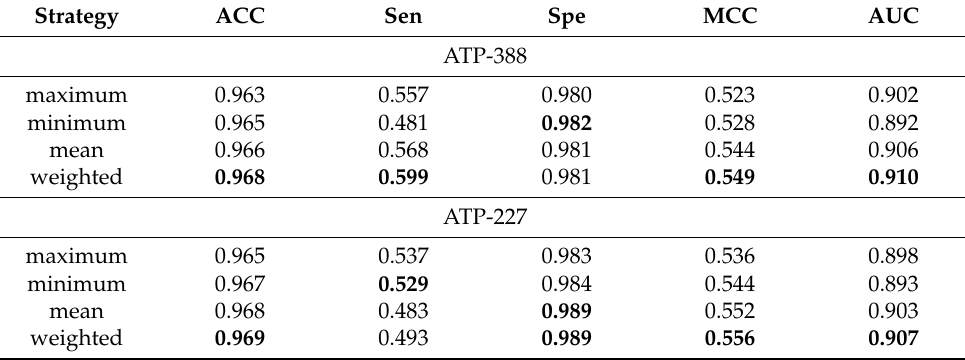
Table 6. Prediction performance of maximum ensemble, minimum ensemble, mean ensemble, and weighted ensemble on ATP-388 and ATP-227 over five-fold cross validation (The highest value of each column in the table is shown in